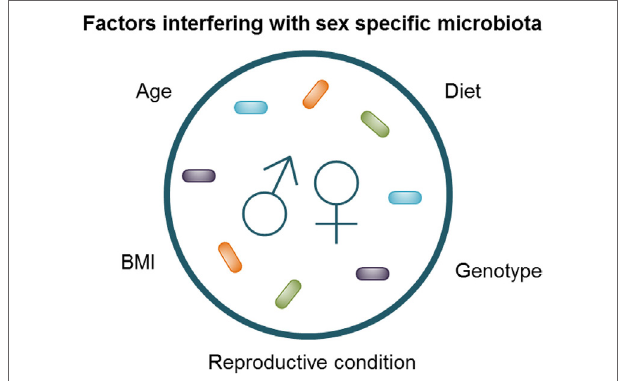
FigURe 2 | Factors interfering with sex-specific microbiota